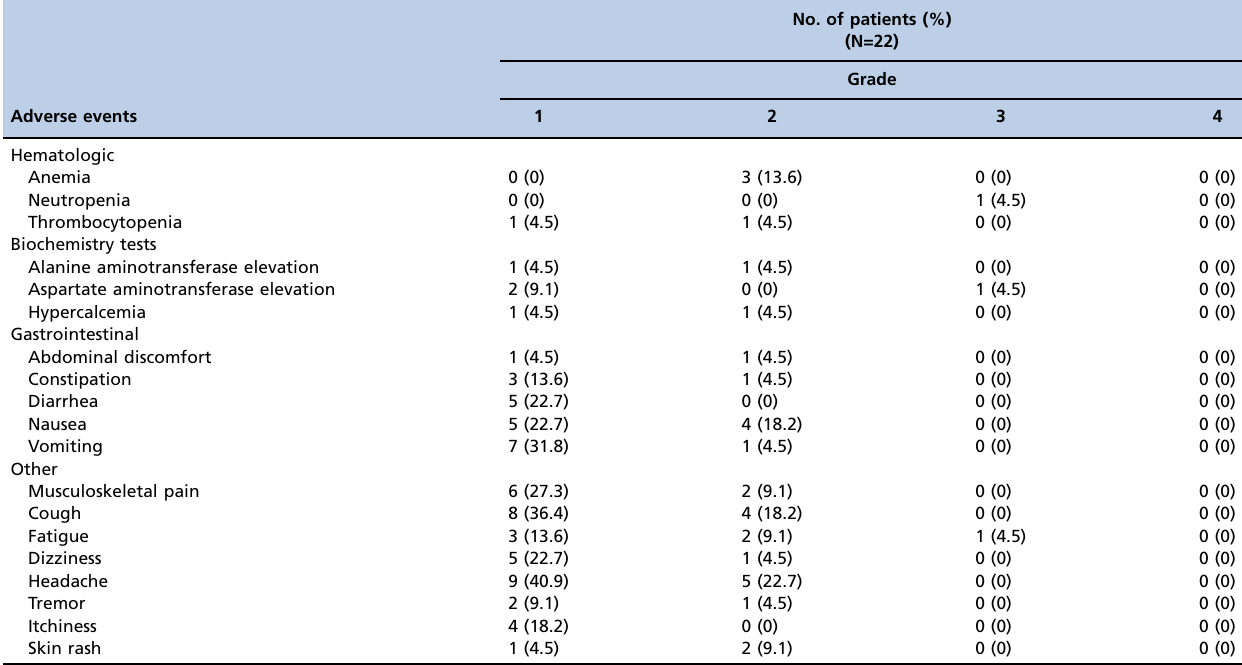
Table 3 - Adverse events classified according to grade in patients with advanced hormone-receptor positive breast cancer treated with anti-Lewis Y monoclonal antibody (hu3S193).